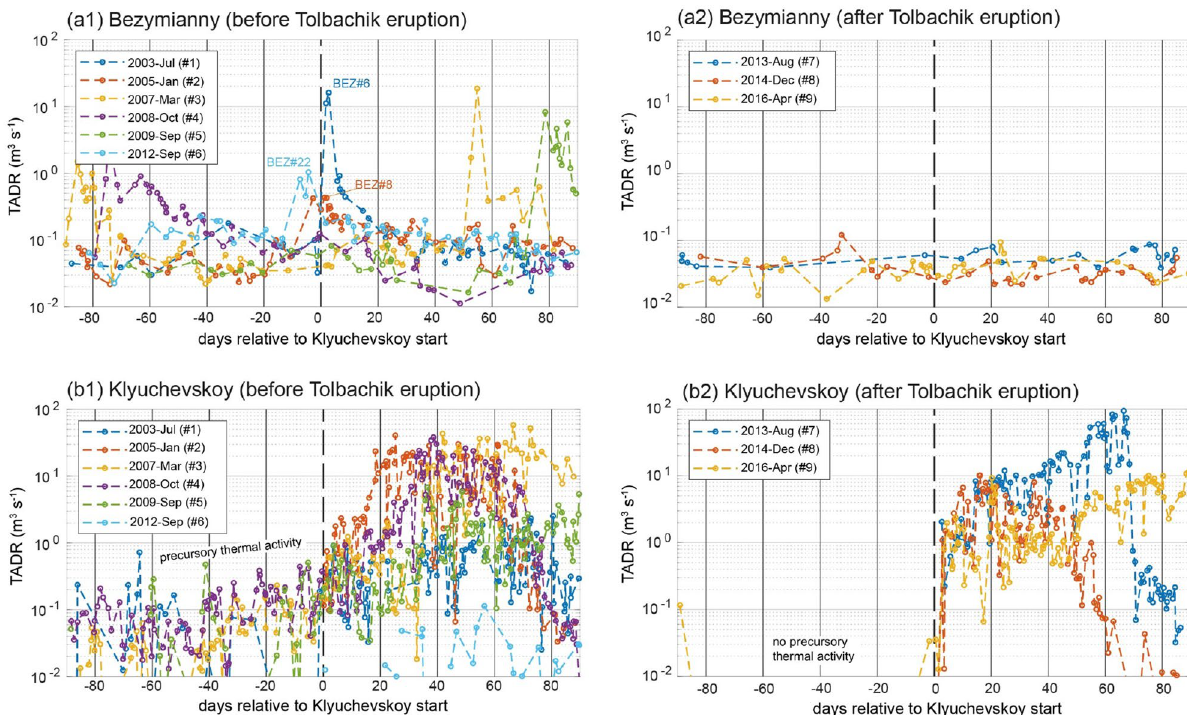
Figure 5. Stacked TADR time-series relative to the onset of the Klyuchevskoy eruptions, before (left column) and after (right column) the Tolbachik eruption. Upper panels : TADRs of the Bezymianny volcano. Lower panels : TADRs of the Klyuchevskoy volcano. The simultaneous activation of Bezymianny at the time of the eruption onset of Klyuchevskoy is obvious before the Tolbachik eruption ( a1 ) but absent afterwards ( a2 ). Similarly, at Klyuchevskoy, the precursory activity is evident for the eruptions that occurred before the Tolbachik eruptions ( b1 ), but not afterward ( b2 ). The time window of ± 90 days is chosen for visualization purposes, because most of the Klyuchevskoy eruptions show their maximum within this time after the eruption onset. Time series generated using MATLAB software (www. mathw orks.